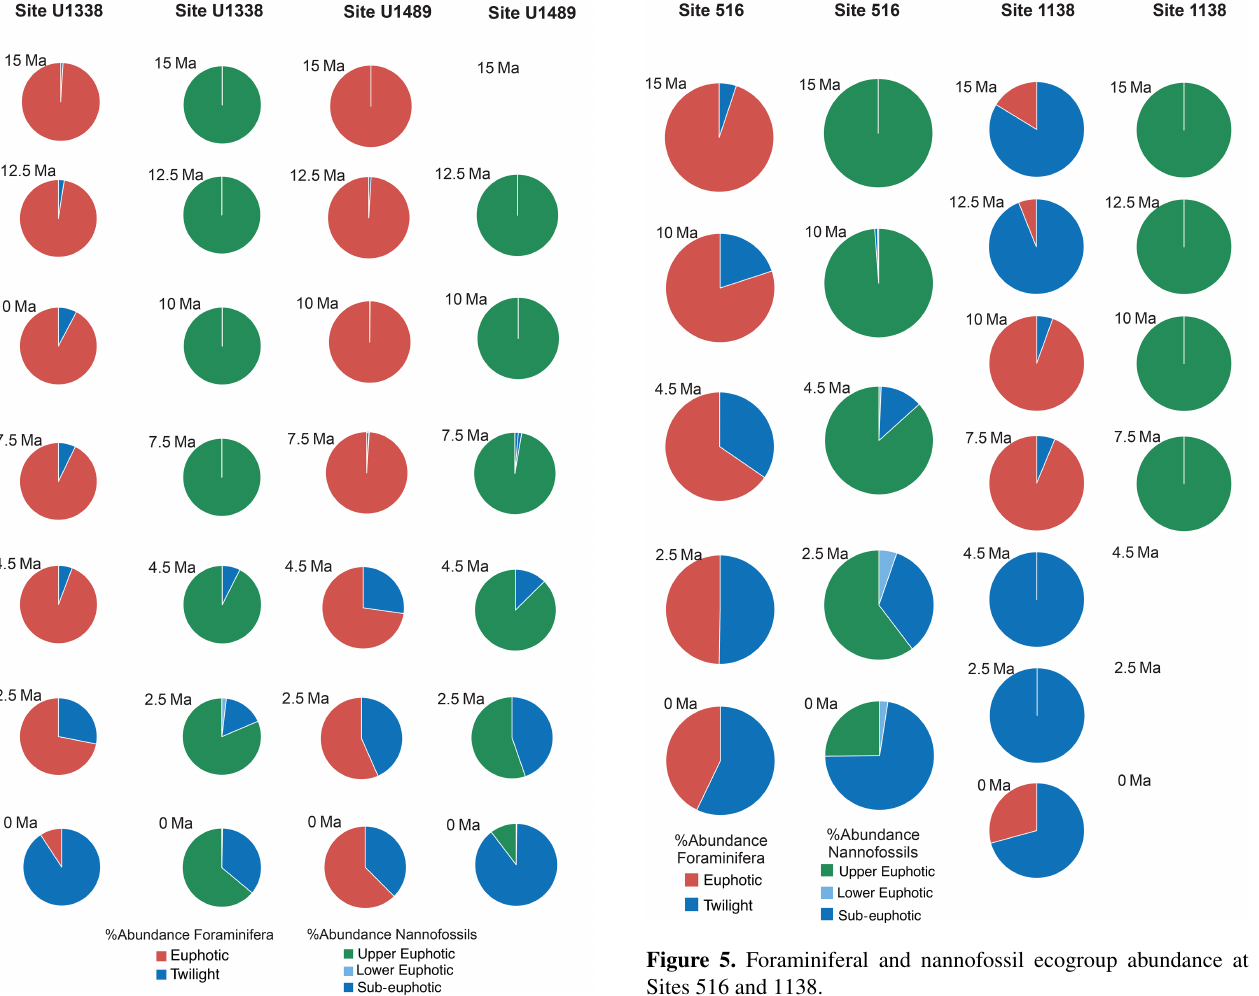
Figure 4. Foraminiferal and nannofossil ecogroup abundance at Sites U1338 and U1489.